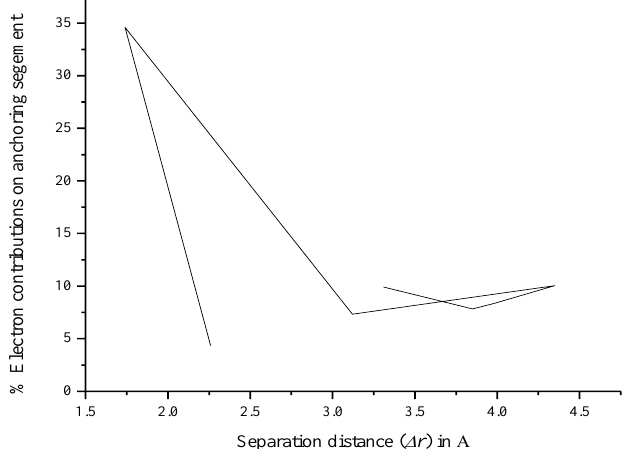
Figure 8. Graphical relationship between single point energy and electron − hole separation distance for the orbital pair within each compound.